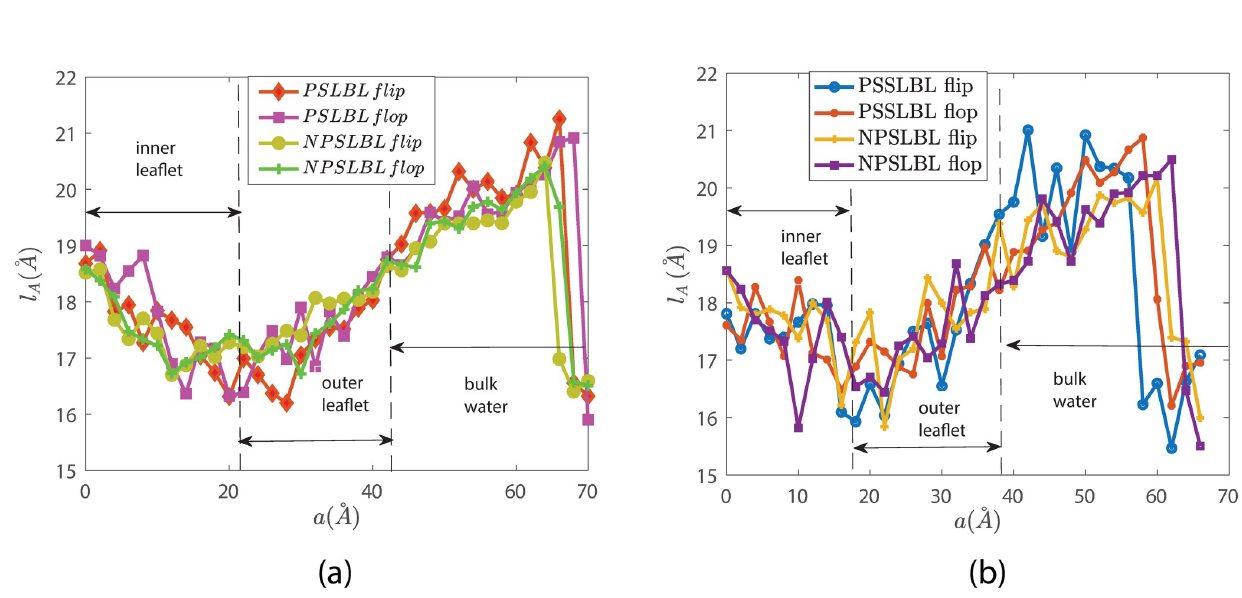
Fig 5. Variation of the tail length l for the star lipid molecules traversing inside and outside the LBL for the NPSLBL and the PSSLBL. l A defined in Fig 1(a) and its caption. Results are shown for systems A (NPSLBL with NP composed of Nda beads) and C (PSSLBL with the planar support composed of Nda beads) in part (a) and for systems B (NPSLBL with NP composed of P5 beads) and D (PSSLBL with the planar support composed of P5 beads) in part (b). Also, in both (a) and (b), we identify the locations of the lipid bilayer and the bulk water. Furthermore, a = 0 Å represents the location of the inner leaflet for both the NPSLBL and the